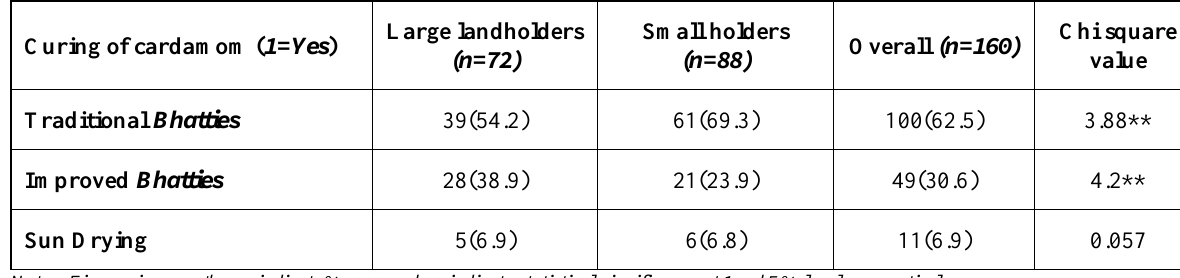
Table 6. Method of curing